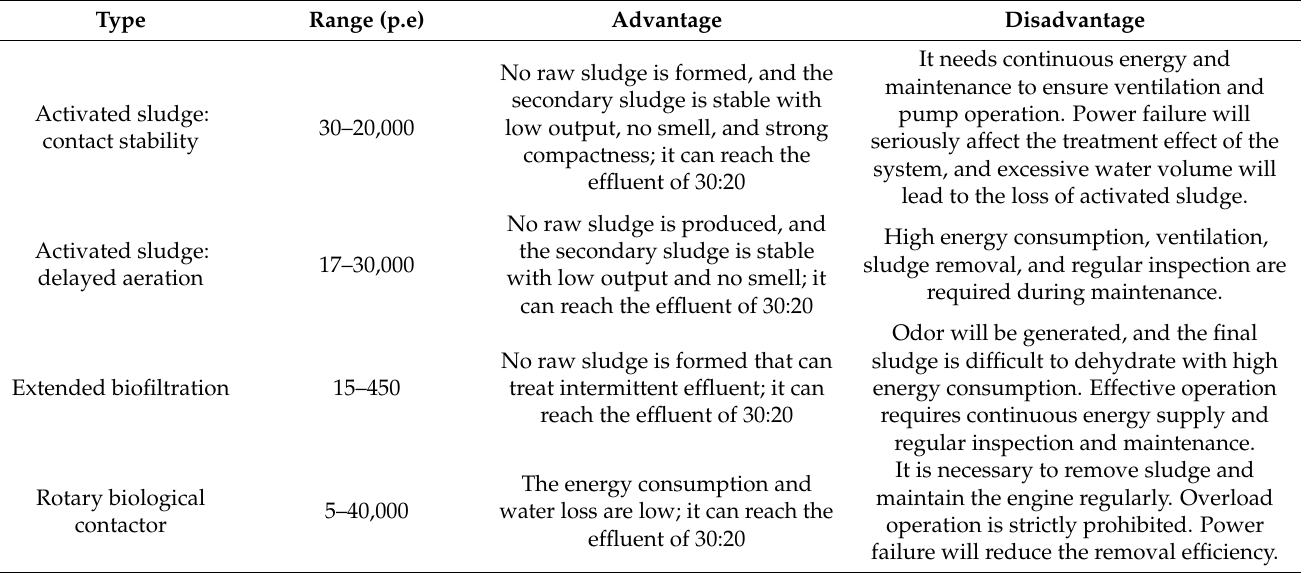
Table 4. Features of small sewage treatment equipment.